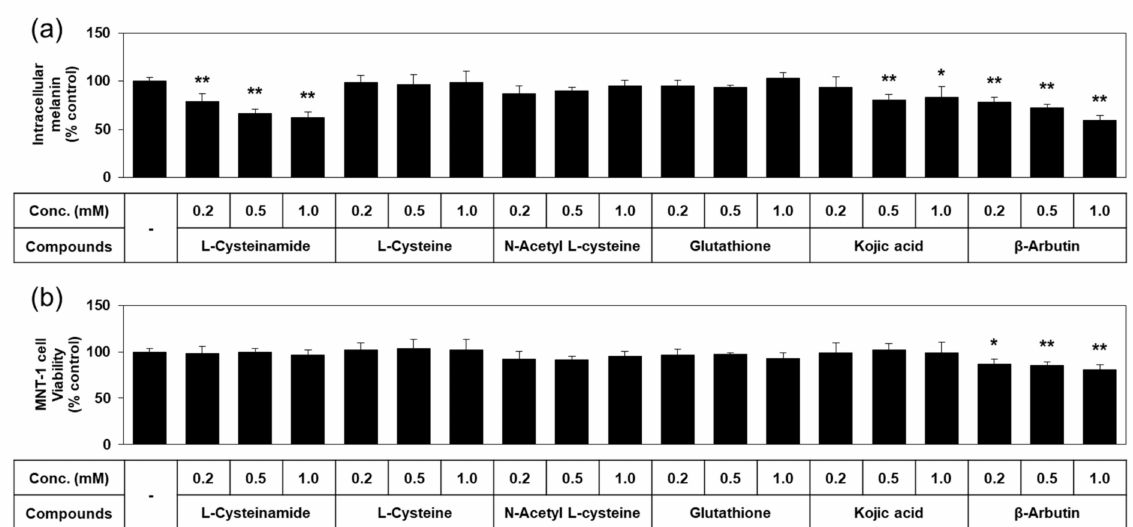
Figure 4. Effects of L-cysteinamide, L-cysteine, N-acetyl L-cysteine, glutathione, kojic acid, and β -arbutin on the melanin content and viability of MNT-1 cells. Cells were treated with vehicle (control) or each substance at the indicated concentra- tions for 72 h. Melanin content ( a ) and cell viability ( b ) are presented as % of control (means ± SD, n = 4). * p < 0.05 vs. control; ** p < 0.01 vs. control.